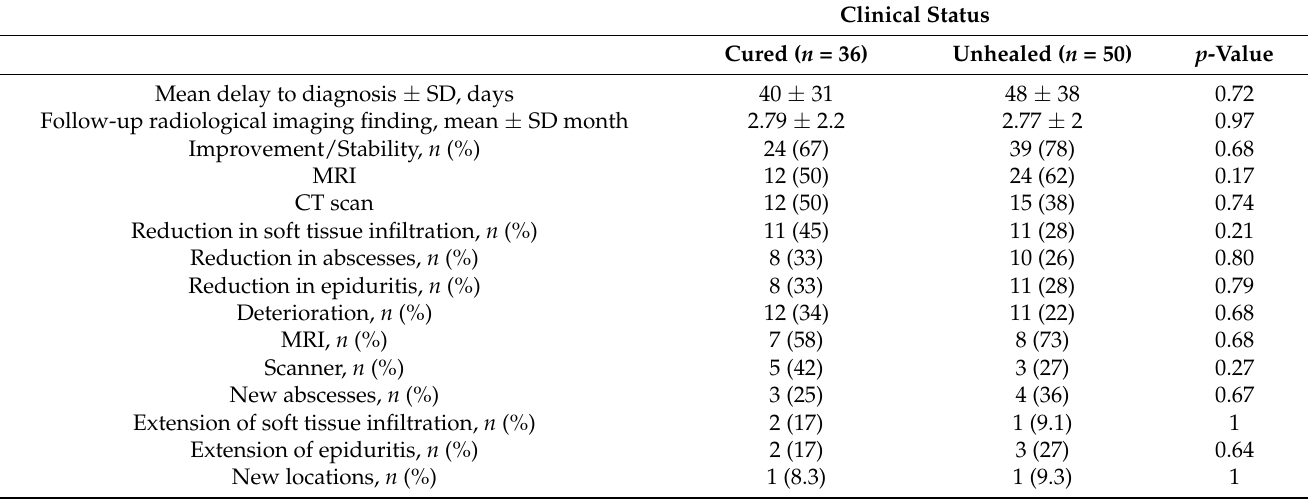
Table 3. Follow-up radiological imaging compared to clinical status.